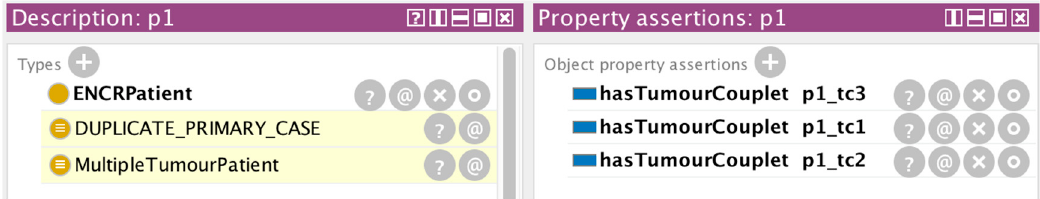
Figure 6. Application of Axiom (A2) alerts the user (via the classification of the patient under DUPLICATE_PRIMARY_CASE) to the fact that patient p1 contains at least one tumour couplet in violation of the MPT rules.